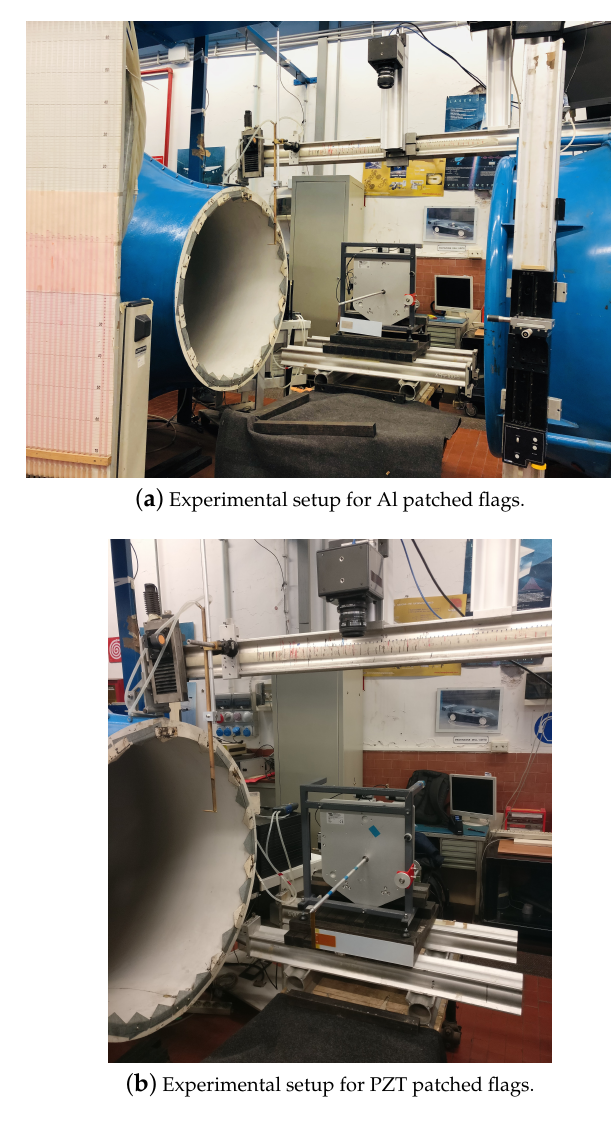
Figure 3. Overall experimental campaign for flag-flutter energy harvesting mechanism carried out in subsonic wind